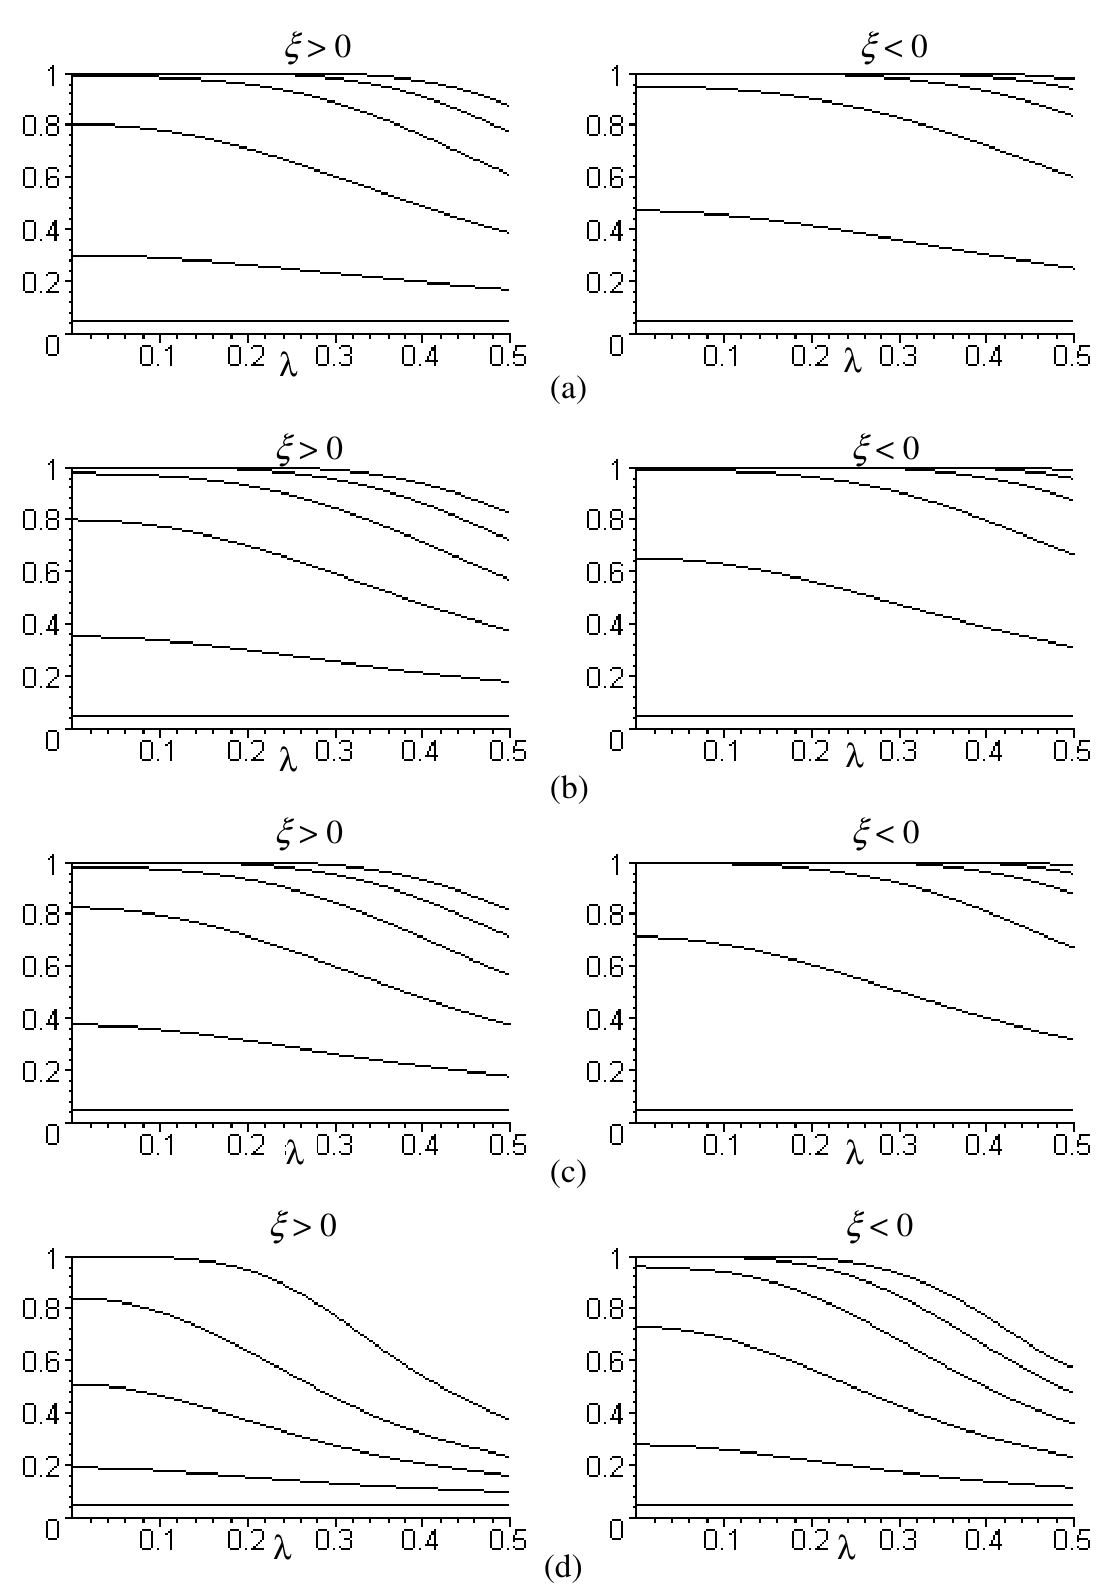
Fig. 3. Plots of π A versus with u = 0 . 5, v = 1 . 2, δ = 0 . 3, r = 1, N = 50, α = 0 . 05, C (cid:2)(cid:2) p ( u, v ) = c (0.20)( c + 1) (bottom to top) for (a) c = 1 and C (cid:2)(cid:2) p = C (cid:2)(cid:2) p ( u, v ); (b) c = 1 and C (cid:2)(cid:2) p = C (cid:2)(cid:2) p ( u, v ) + 0 . 33; (c) c = 1 and C (cid:2)(cid:2) p = C (cid:2)(cid:2) p ( u, v ) + 0 . 5; (d) c = 1 . 5 and C (cid:2)(cid:2) C (cid:2)(cid:2) u, v ); (e) c = 1 . 5 and C (cid:2)(cid:2) C (cid:2)(cid:2) u, v ) + 0 . 33; (f) c = 1 . 5 and C (cid:2)(cid:2) p = p ( p = p (